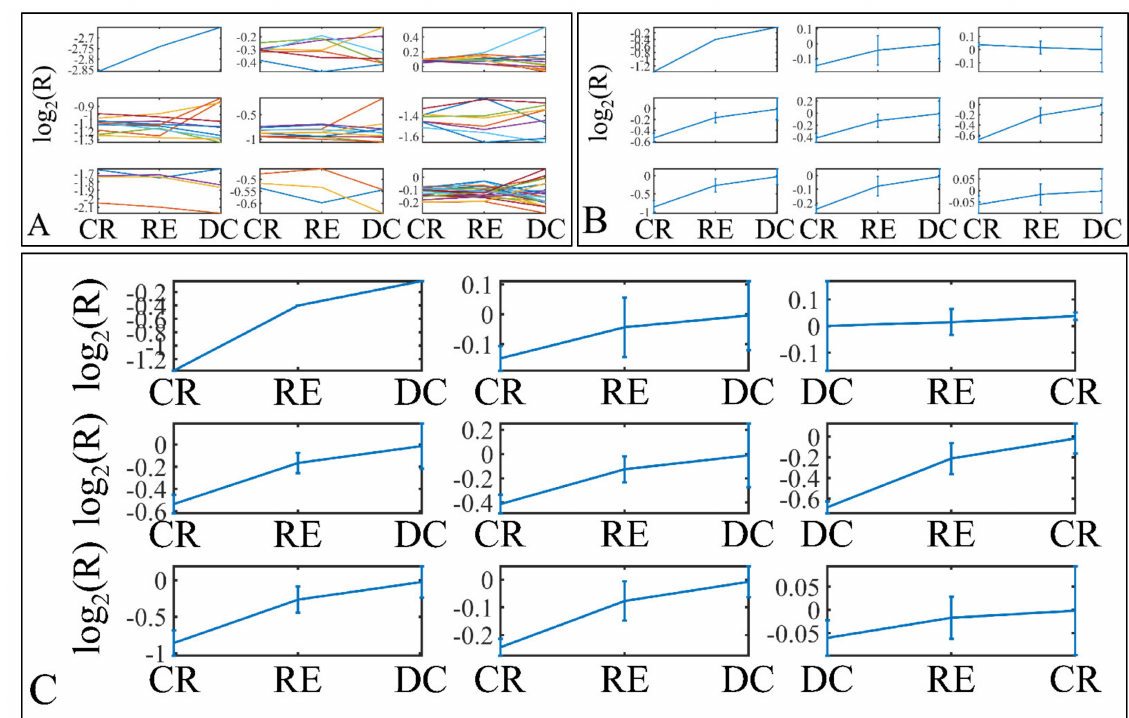
Figure 14. Descriptive k-means of patient survival. Tumor samples were clustered with respect to the patients’ survival profile ( A , B ). The first representation concerns the k-means classification of the miRNA expression data ( A ), whereas it is followed by the k-means centroids ( B ). The centroids in ( B ) represent the mean values of the k-means clusters depicted in ( A ). Those centroids (depicted in ( B )) were sorted in an ascending order, in an attempt to find patterns related to patient survival ( C ). Similarly to tumor staging, an ascending miRNA expression pattern from clinical remission to deceased patients was observed ( C ) (Legend: CR: Clinical remission ( n = 36); RE: Relapse ( n = 12); DC: Deceased ( n =